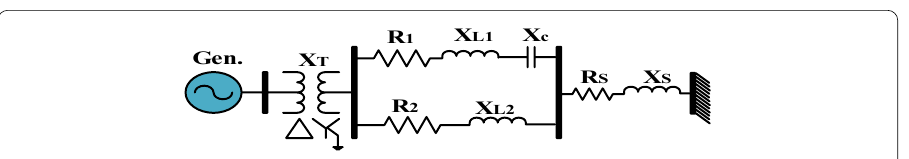
Fig. 11 IEEE second benchmark electrical